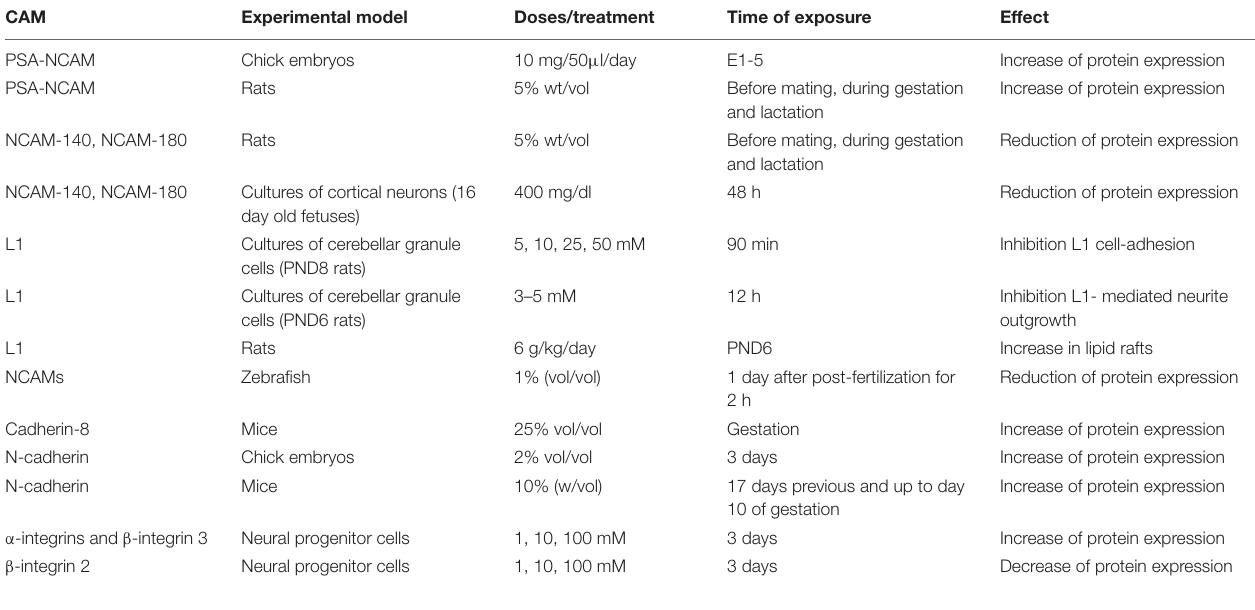
TABLE 2 | Prenatal alcohol exposure modulates CAMs expression in ex vivo and in vivo experimental